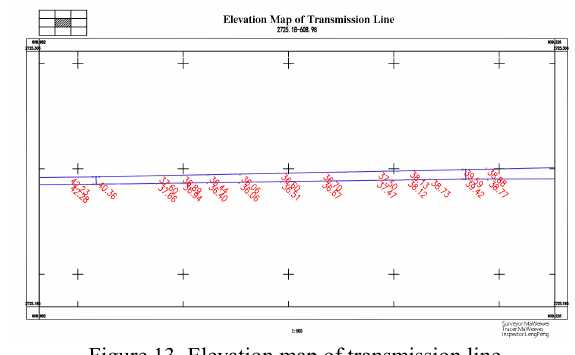
Figure 13. Elevation map of transmission line